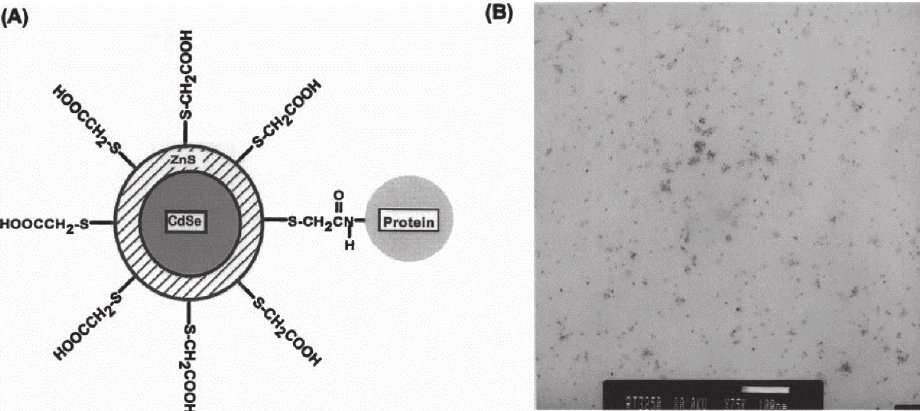
Figure 3: (a) Schematic diagram of CdSe QD capped by ZnS covalently coupled with thioglycolic acid and protein. (b) TEM of QD-transferin (an iron transport protein) conjugates. Reprinted image with permission from Ref. [34], Copyright 1998,